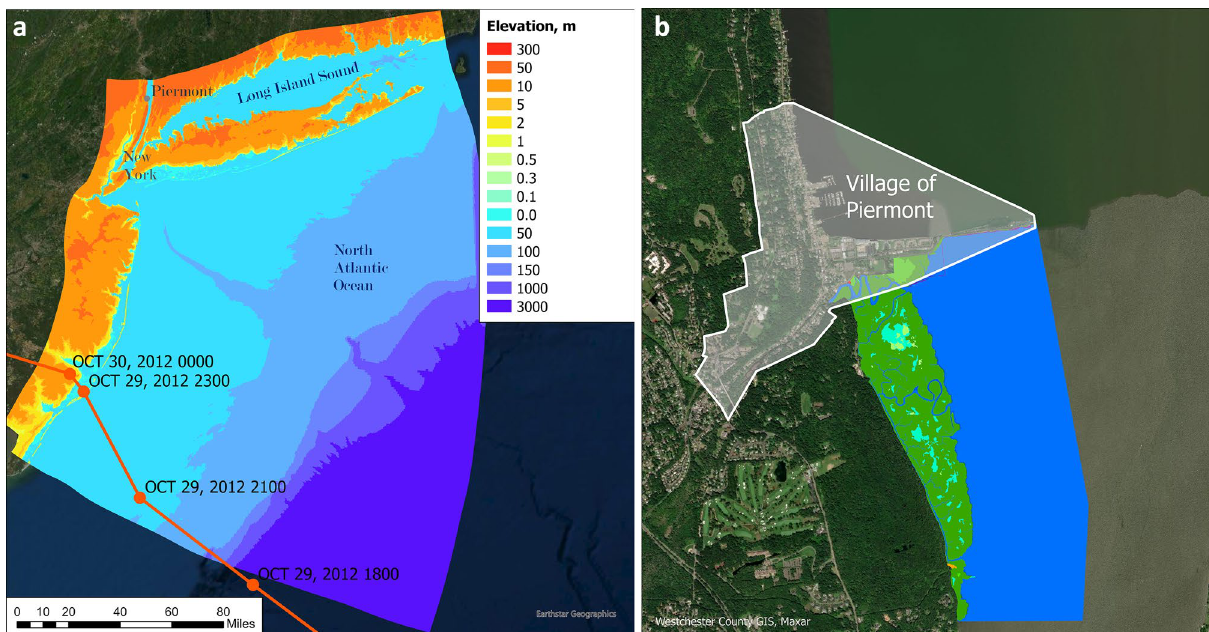
Figure 1. ( a ) NJ/NY/CT coastal domain and Hurricane Sandy (October 2012) track (left) (ArcGIS basemap credit: Earthstar Geographics). ( b ) Piermont Village and Marsh (right) (ArcGIS basemap credit: Westchester County GIS,